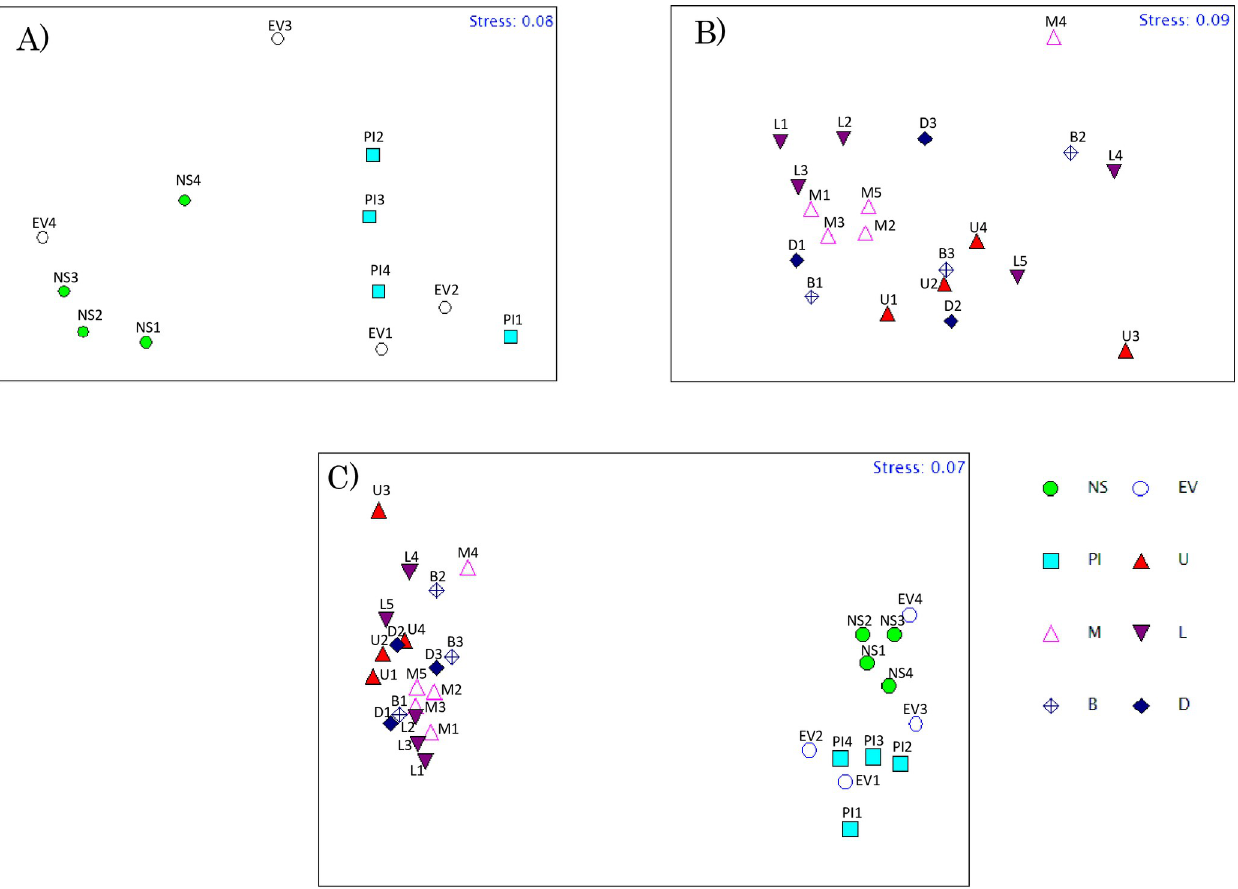
Fig 3. MDS analysis of the microbiome profiles of crab intestines and sediments. A) Crab intestines. B) Sediment regions. C) The combined graph of crab intestines and sediments. The symbols NS, EV, PI indicate the profiles of N . smithi , E . versicolor , and P . indiarum intestine, whereas U, M, L, B, and D denote the upper, middle, lower, burrow, and dug region, respectively. In ANOSIM analysis (permutations = 9999), the value for sample statistic (Global R) and significance level of sample statistic were (0.343 and 0.041), (0.025 and 0.369), and (0.529 and 0.001) for A), B), and C) respectively.